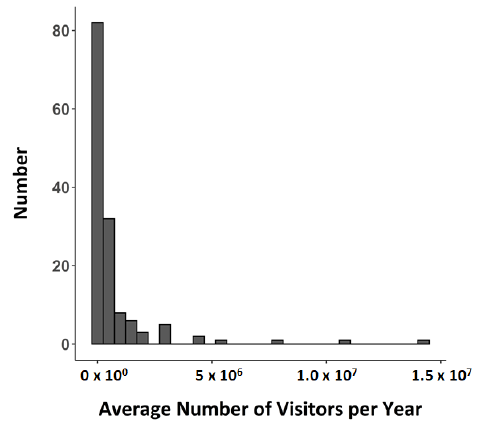
Figure A2. Histogram of the average number of visitors per year.